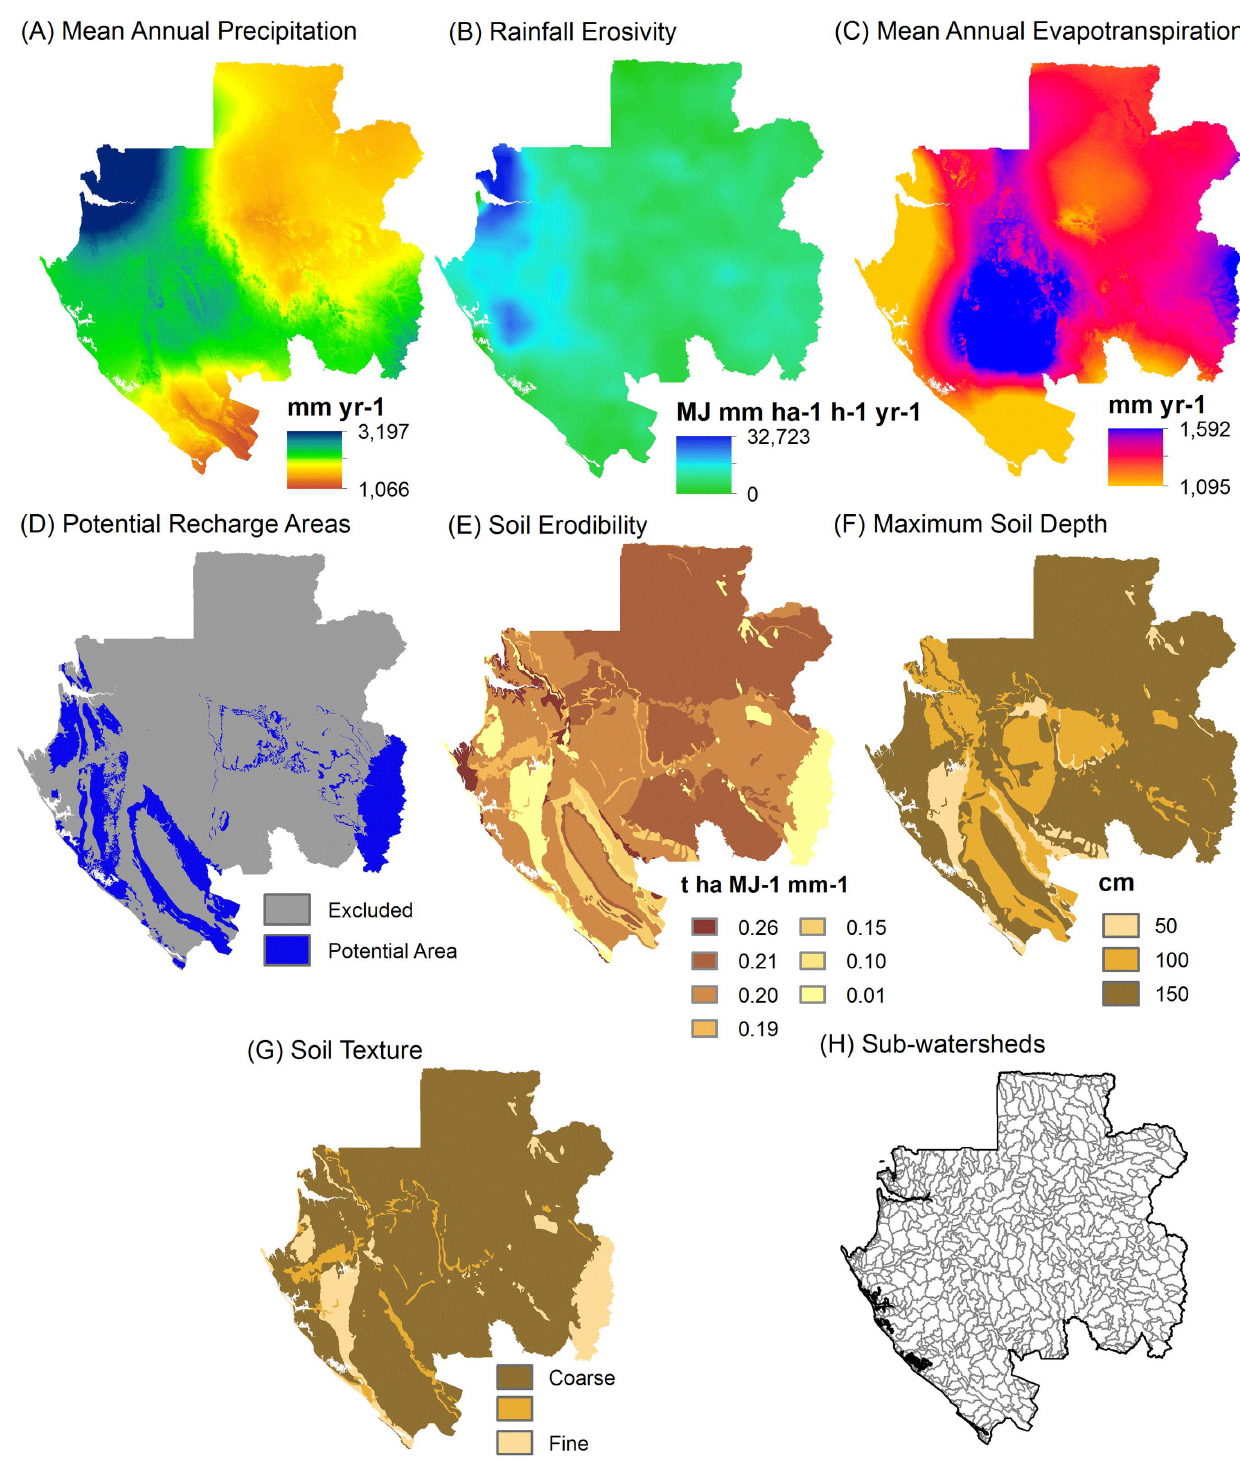
Fig 1. Spatial biophysical inputs for hydrologic ecosystemservicesmodeling. Data sources are describedin the main text.